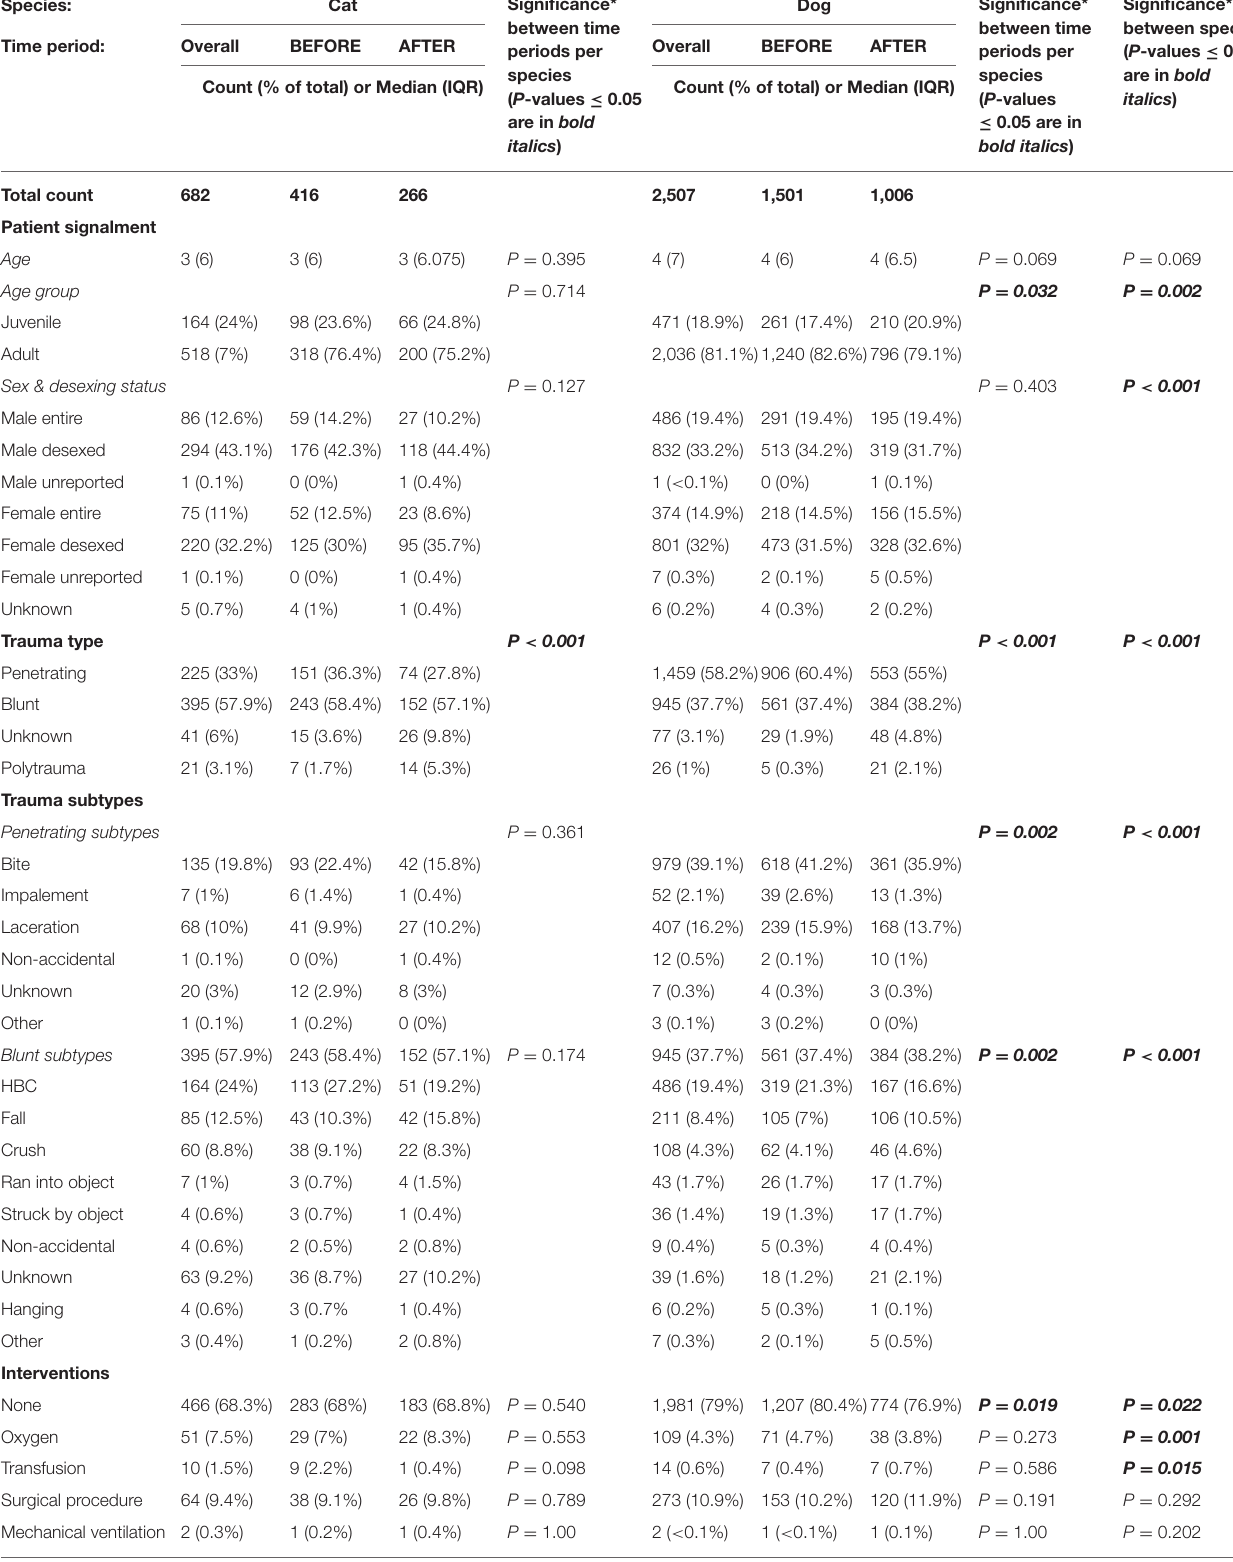
TABLE 3 | Patient characteristics, interventions, and outcomes by species.